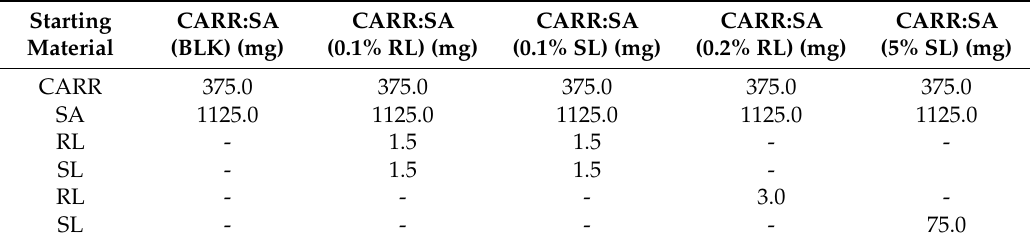
Table 1. Composition of polymers and BSs used in selected optimized freeze-dried wafers obtained from composite CARR:SA gels (1.5% w / w total